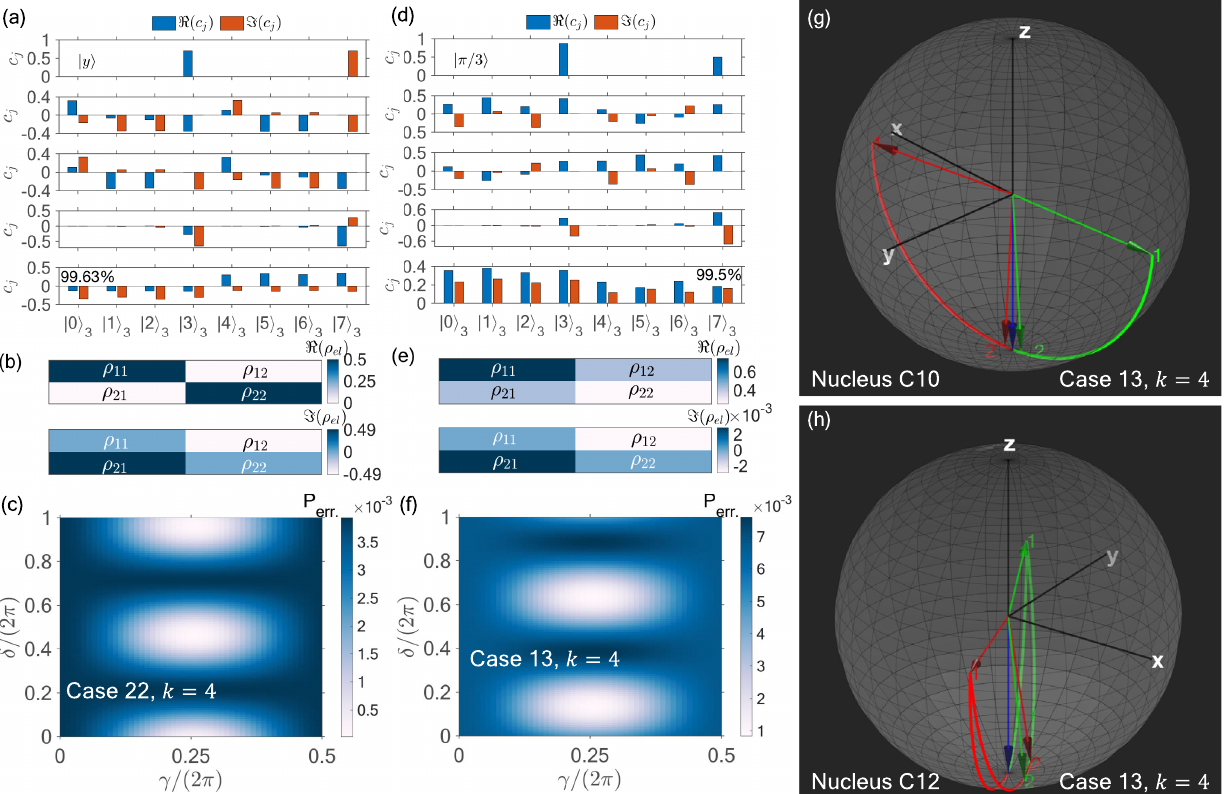
FIG. 10. Three-qubit bit-flip code using the CR multispin operations. The electron ’ s state is encoded into three physical qubits, two xz of which correspond to the 13 C atoms C10 and C12. (a) Recovery of the electron state j y i [case 22, k ¼ 4 in Fig. 8]. (d) Recovery of the electron state j π = 3 i ¼ cos ð π = 6 Þj 0 i þ sin ð π = 6 Þj 1 i [case 13, k ¼ 4 in Fig. 8]. From top to bottom, (a),(d) show the coefficients of the initial, encoded, error, decoded, and corrected state. Blue (red) bars are the real (imaginary) parts of the coefficients. The probability to measure the electron in j y i in (a) is 99.63% while to measure it in j π = 3 i in (d) is 99.5%. Real and imaginary components (b),(e) of the 2 of measuring the ψ final reduced density matrix of the electron verify the recovery of the initial state. Error probability 1 − jh ψ el ; 0 j final ij incorrect state of the electron at the end of the QEC code for case 22 and k ¼ 4 (c) and for case 13 and k ¼ 4 (f). j ψ is defined as el ; 0 i cos ð γ = 2 Þj 0 i þ e i δ sin ð γ = 2 Þj 1 i . Evolution of 13 C atoms C10 (g) and C12 (h) up to the decoding step, when the electron undergoes a bit flip. The initial state is j 1 i for each nucleus (blue arrow). The nuclei follow the green curve evolution if the electron is initially in j 0 i or the red curve evolution if it is initially in j 1 i . After an error happens on the electron and we perform the decoding, the nuclei approximately return to j 11 i such that the subsequent Toffoli gate corrects the bit-flip